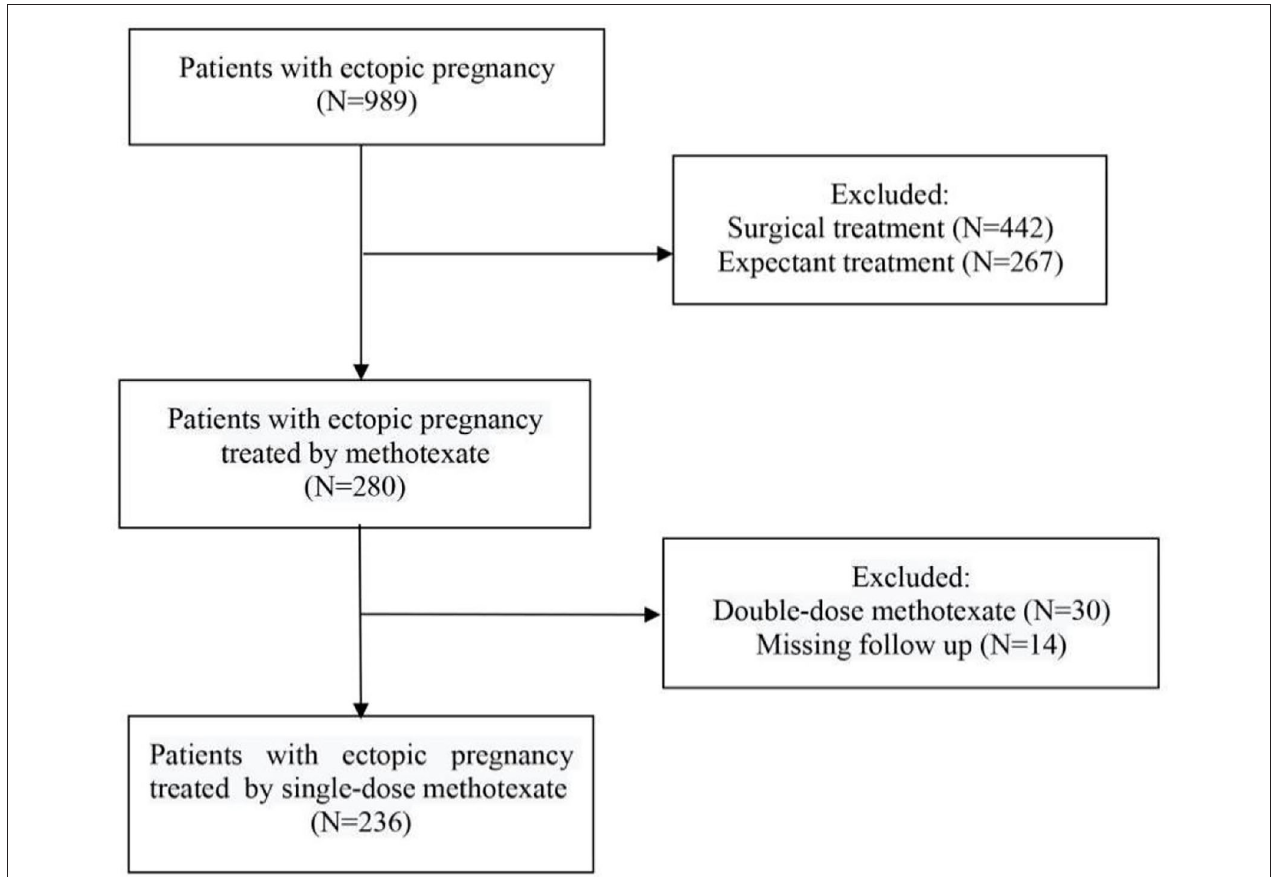
FIGURE 1 | Study flowchart. This figure shows the procedure of patient selection.